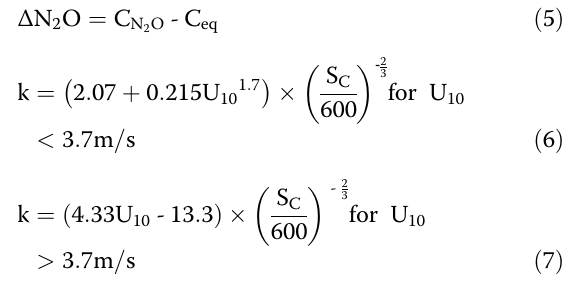
Table S2). Sc denotes viscosity coefficient of N ninkhof 2014; Eq. 9).